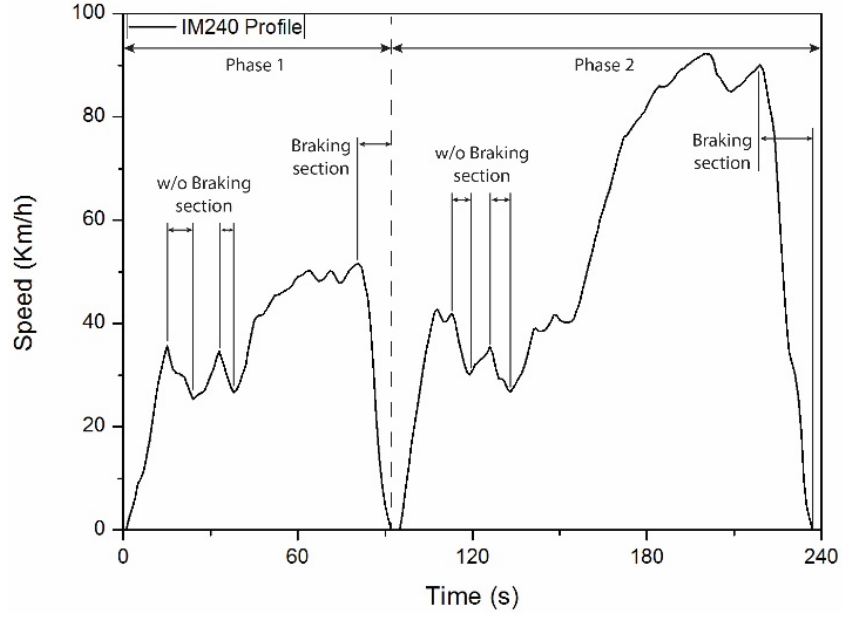
Figure 1. IM240-mode Figure 1. IM240 ‐ mode profile.